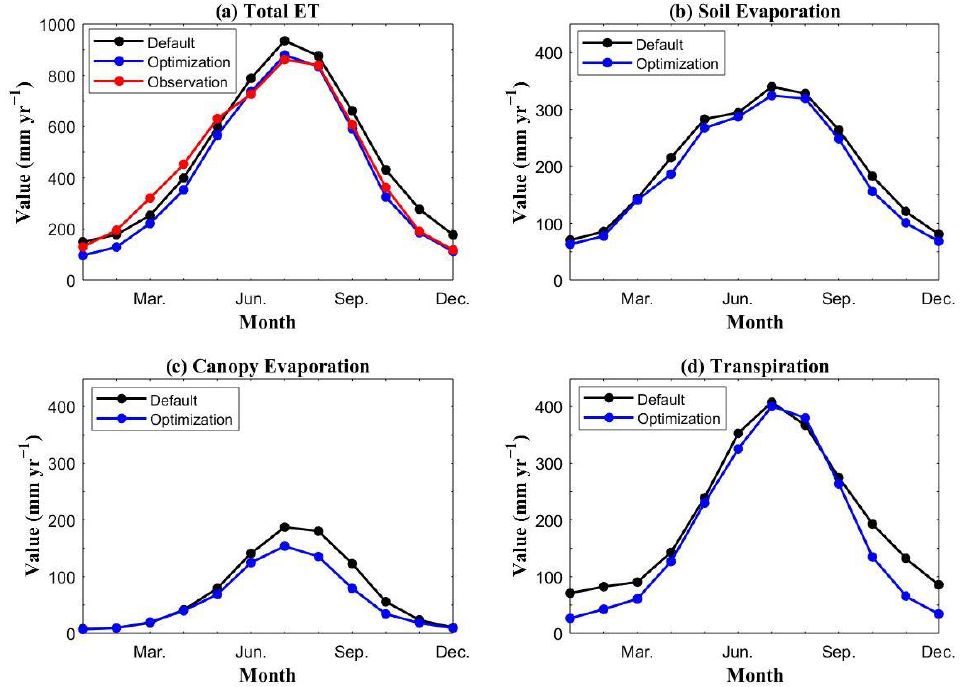
Figure 6. Comparisons between mean monthly evapotranspiration simulated values for 2009–2011 using Community Land Model version 4.0 model with default and optimal parameters for: ( a ) total evapotranspiration, ( b ) soil evaporation, ( c ) canopy evaporation, and ( d ) transpiration.